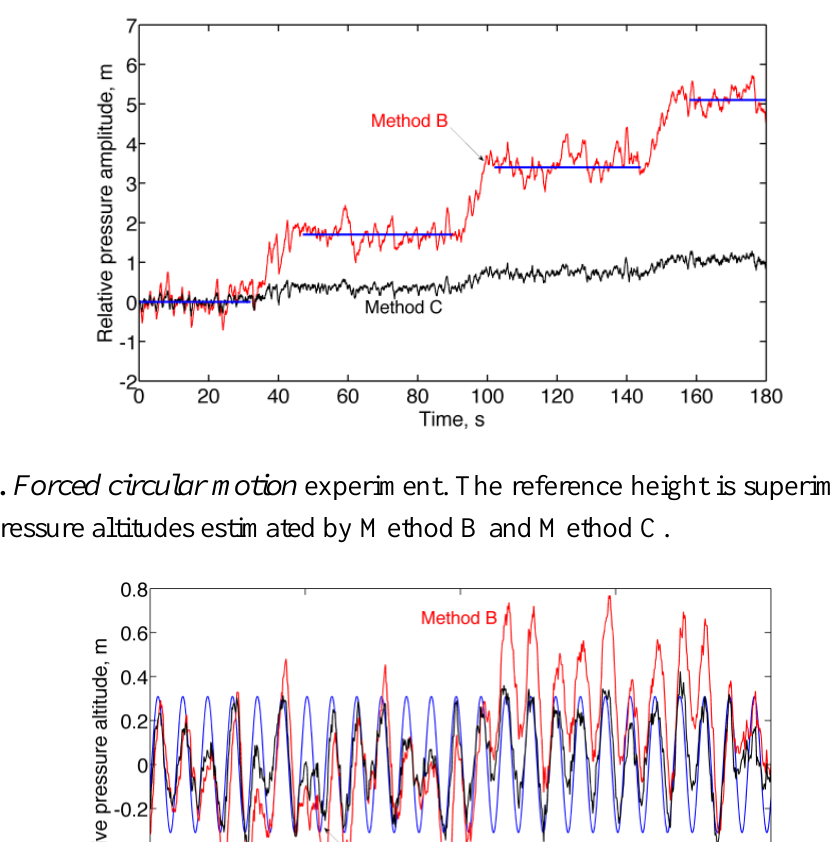
Figure 6. Stair-walking experiment. Transitions to higher-level floors from the ground floor are visible in the relative pressure altitudes estimated by Method B and Method C. Horizontal lines indicate the reference height of the floors relative to ground floor.